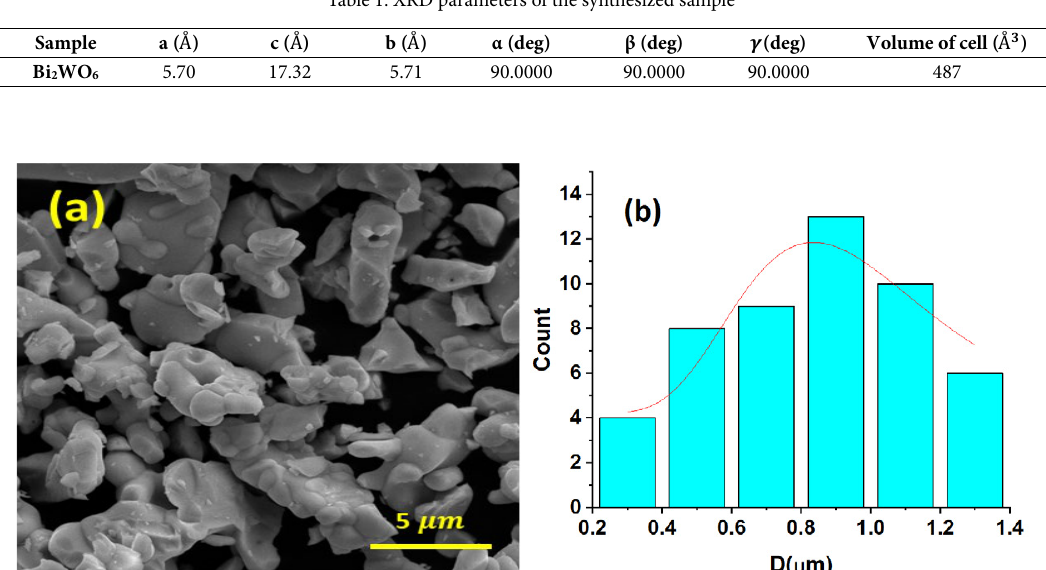
Fig. 3. FEEM image, and (b) size distribution of Bi Figure 3. FEEM image, and (b) size distribution of Bi 2 WO 6 NPs